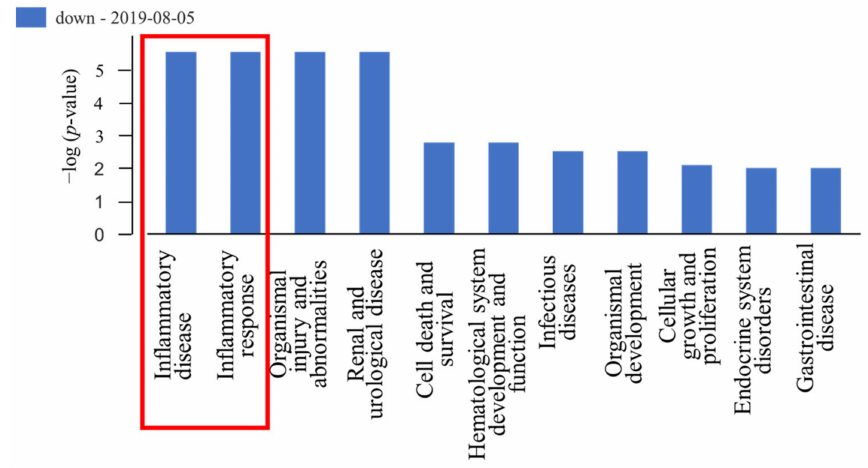
Figure 3. Pathway analysis. Ingenuity pathway analysis showed that the top two diseases related to downregulated miRNAs at day 7 in the patients were inflammatory disease and inflammatory response (red box).